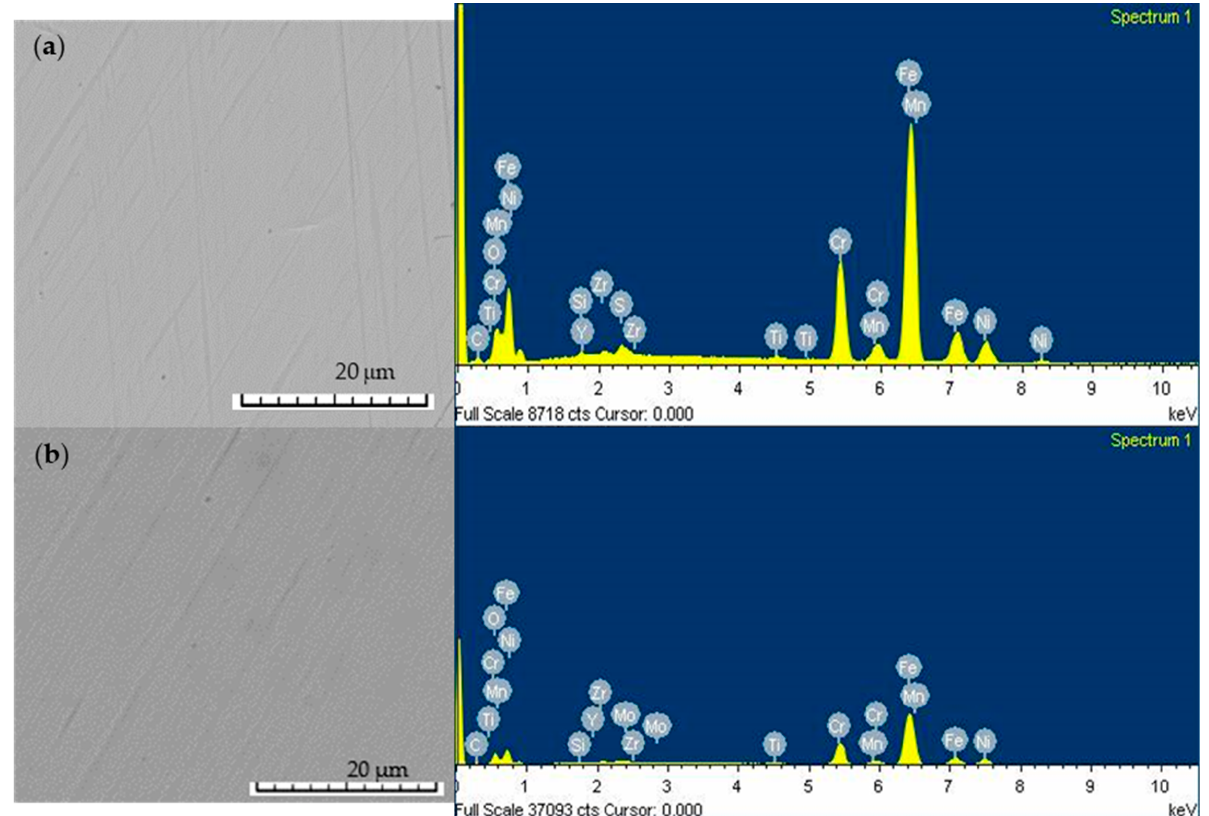
Figure 2. SEM images and EDX spectra of deposited single layer sol–gel TiO 2 –ZrO 2 films on AISI 316L stainless steel: ( a ) annealed at 400 °C; ( b ) annealed at 600 °C.